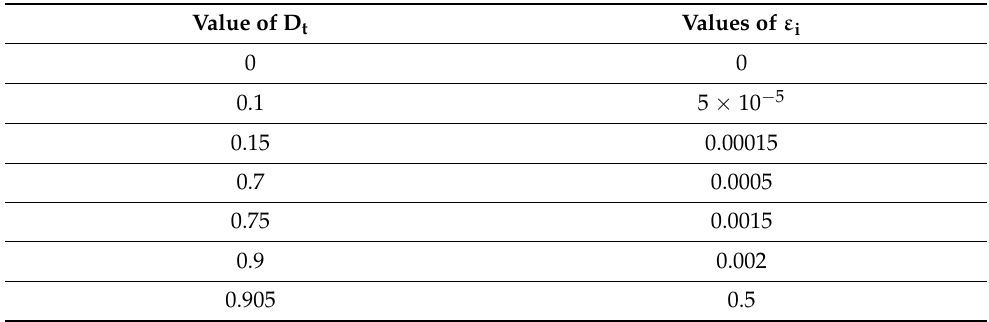
Table 2. Values of parameters of damage evolution under tension.